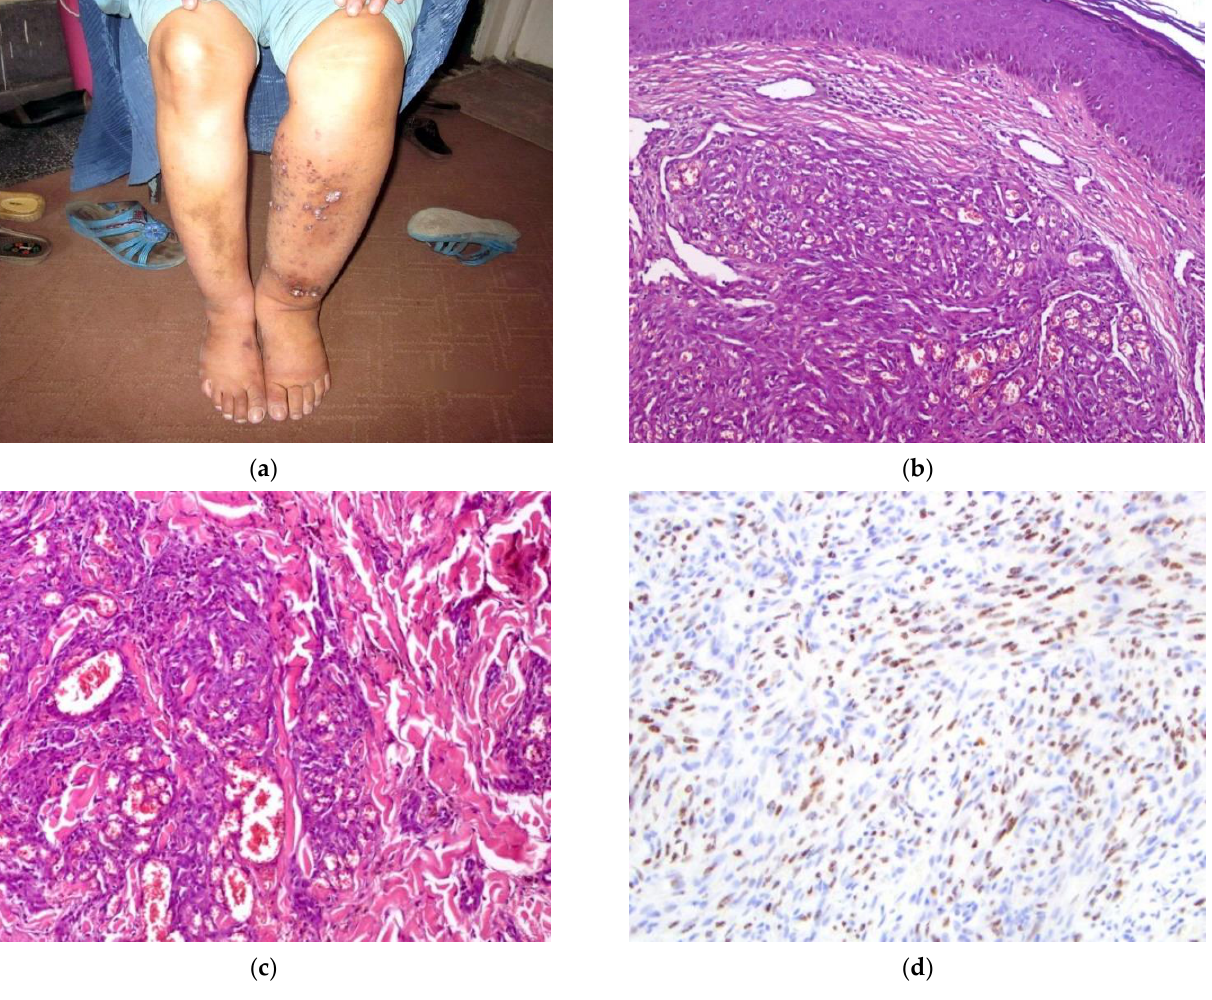
Figure 3. ( a – d ) Patient #3. Image ( a ) Multiple violaceous patches, nodules, and papules in the setting of unilateral lymphedema in the left lower extremity. Image ( b ) H&E 40 × . Nodules of uniform spindle cells in a fascicular pattern. Image ( c ) H&E 100 × . Area of nodularity located in deep dermal tissues. No significant RBC extravasation is identified. Image ( d ) IHC HHV-8 200 × . Strong and diffuse nuclear staining of spindled cells within the